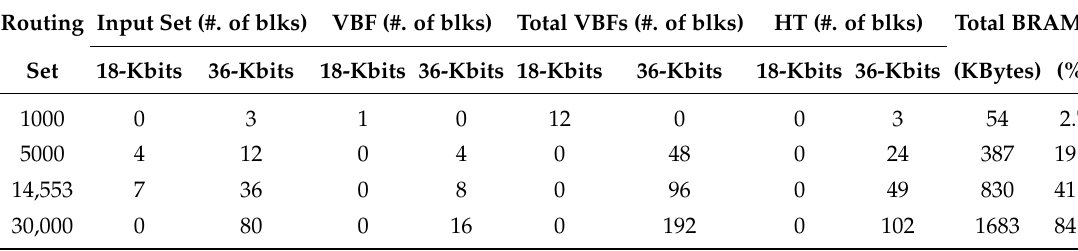
Table 8. Memory requirement in hardware.